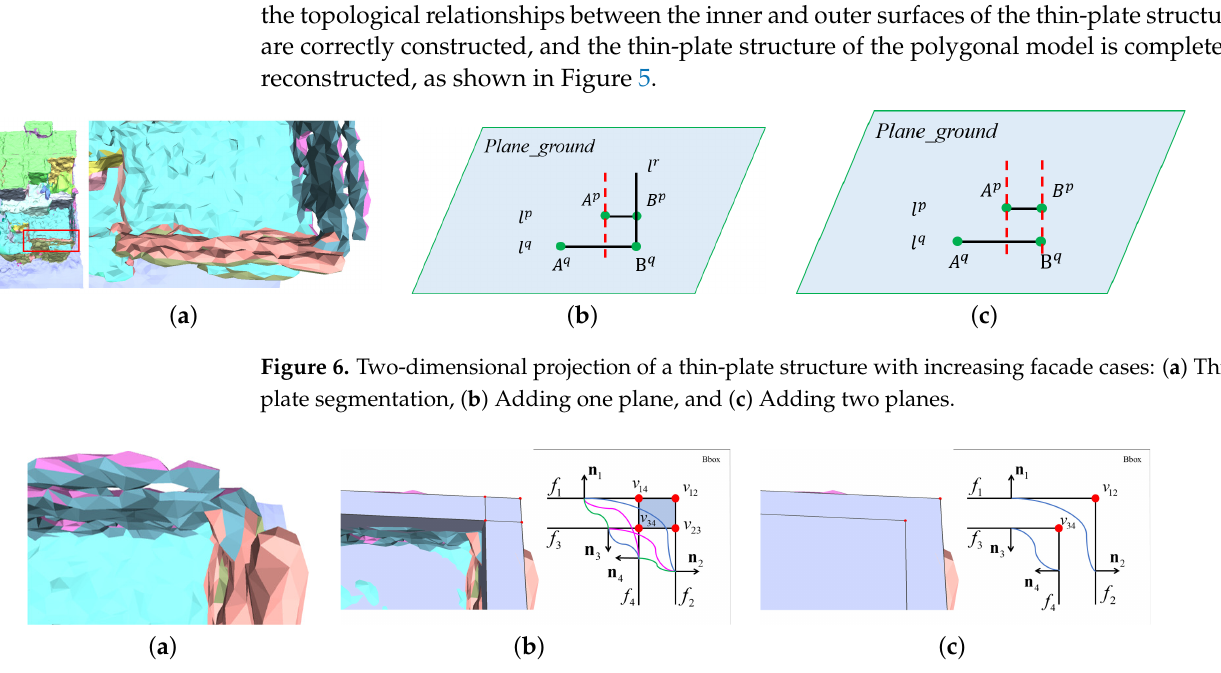
Figure 7. Topology connection correction for thin-plate structures: ( a ) Thin-plate segmentation, ( b ) The wrong topology connection, and ( c ) Corrected topology